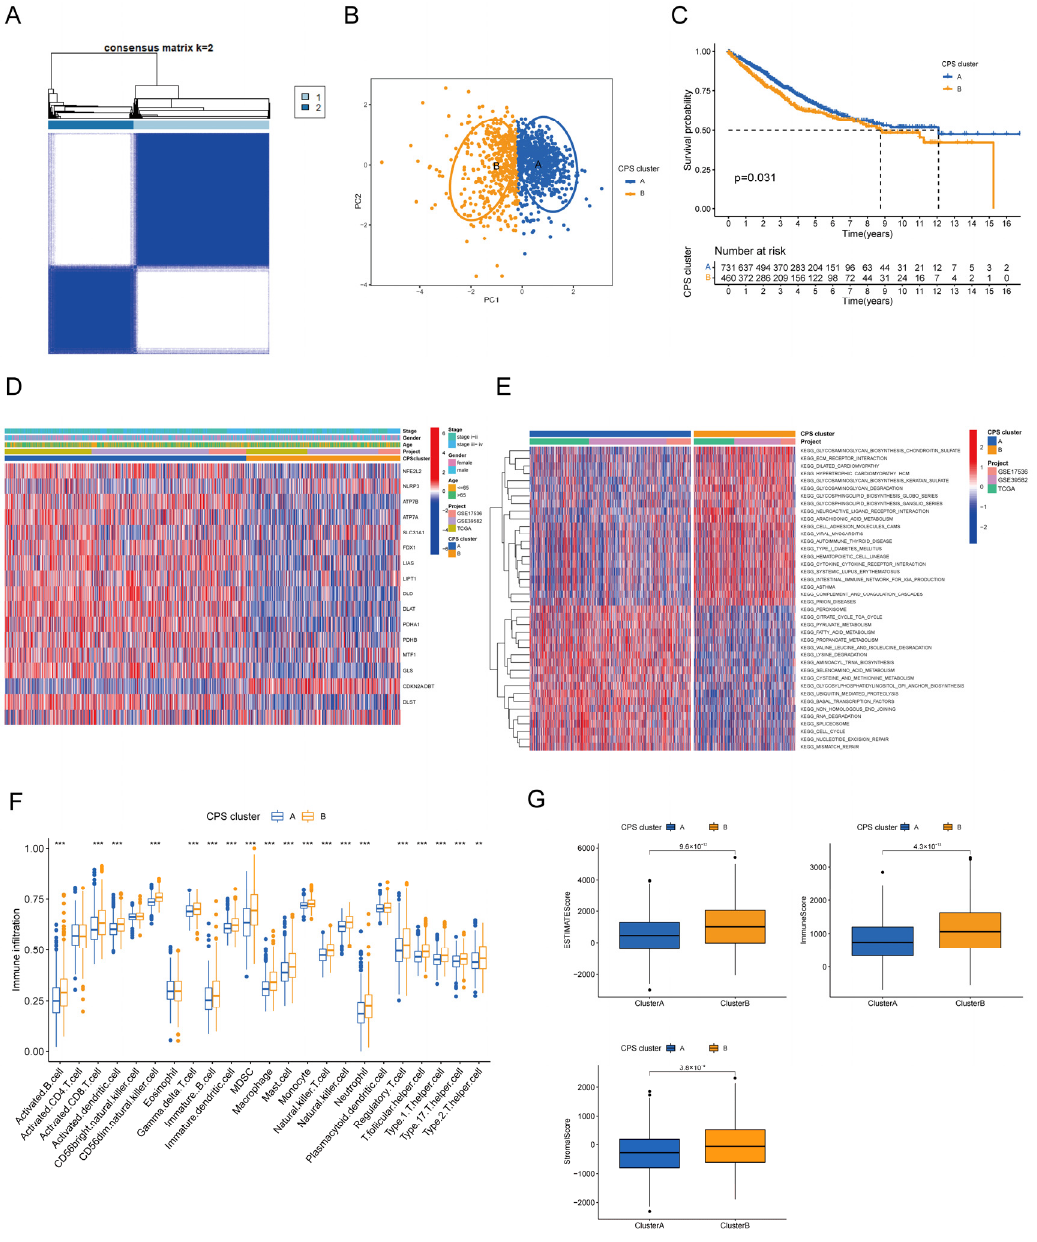
Figure 3. Identification of cuproptosis modification patterns in colorectal cancer by consensus cluster- ing. ( A ) Two clusters were identified by consistent clustering analysis (k = 2). ( B ) Principal component analysis shows a different distribution between the two subtypes. ( C ) Kaplan–Meier survival curves of patients with different cuproptosis modification patterns. ( D ) Differences in clinicopathological characteristics and expression levels of CRs between the two cuproptosis subgroups. ( E ) Gene set variation enrichment analysis of patients with different cuproptosis modification patterns for ascer- taining the activation status of biological pathways. ( F ) The abundance of immune cell infiltration between the different molecular subtypes. ( G ) ESTIMATE score, immune score, and stromal score between different molecular subtypes. CR, cuproptosis-associated regulator; ** p < 0.01; *** p <